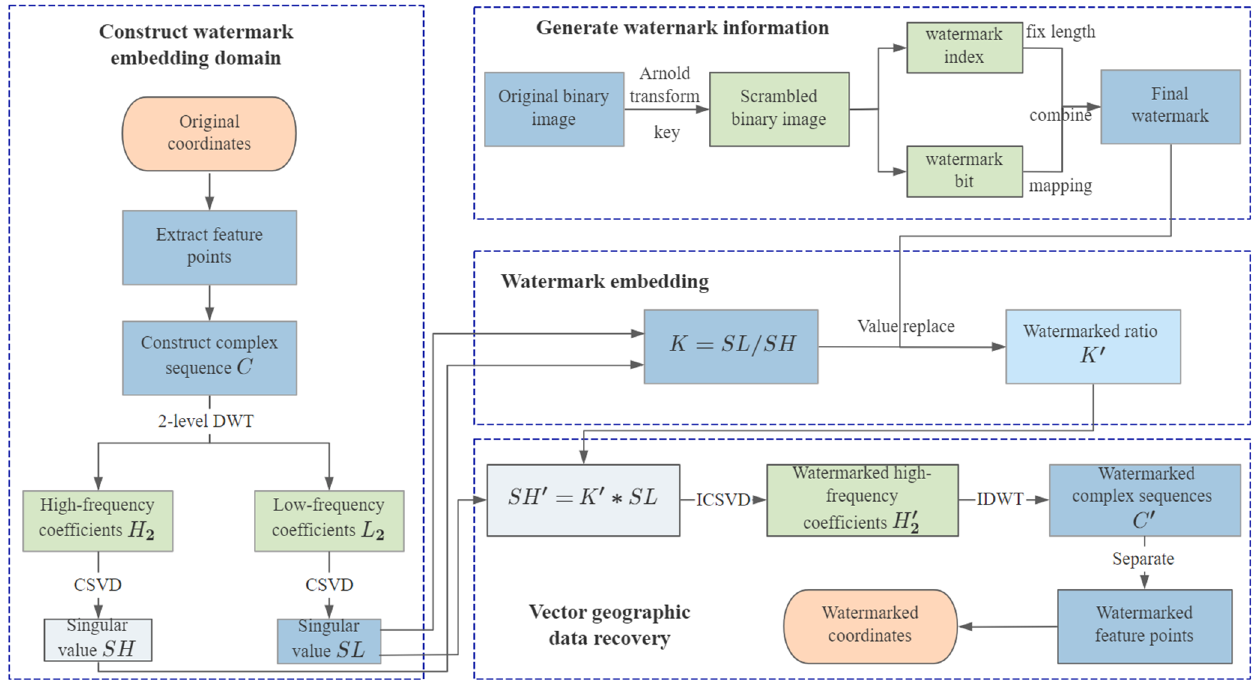
Figure 4. Flow chart of watermark embedding algorithm.